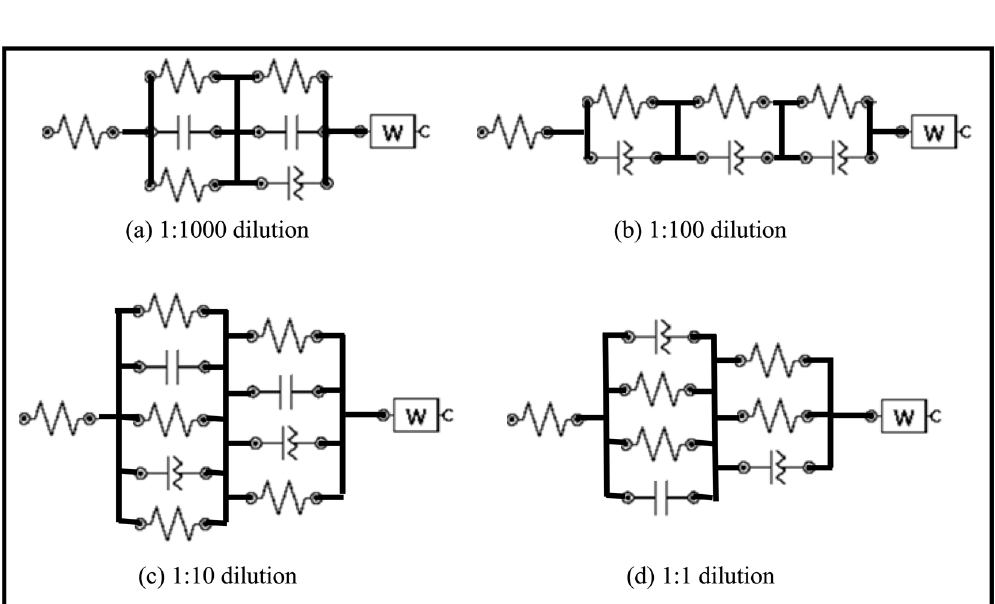
Figure 7. Equivalent circuit for CdSe/ZnS-MAA-EDC/NHS-COX modified GCE in ( a ) 1:1000, ( b ) 1:100, ( c ) 1:10 and ( d ) 1:1